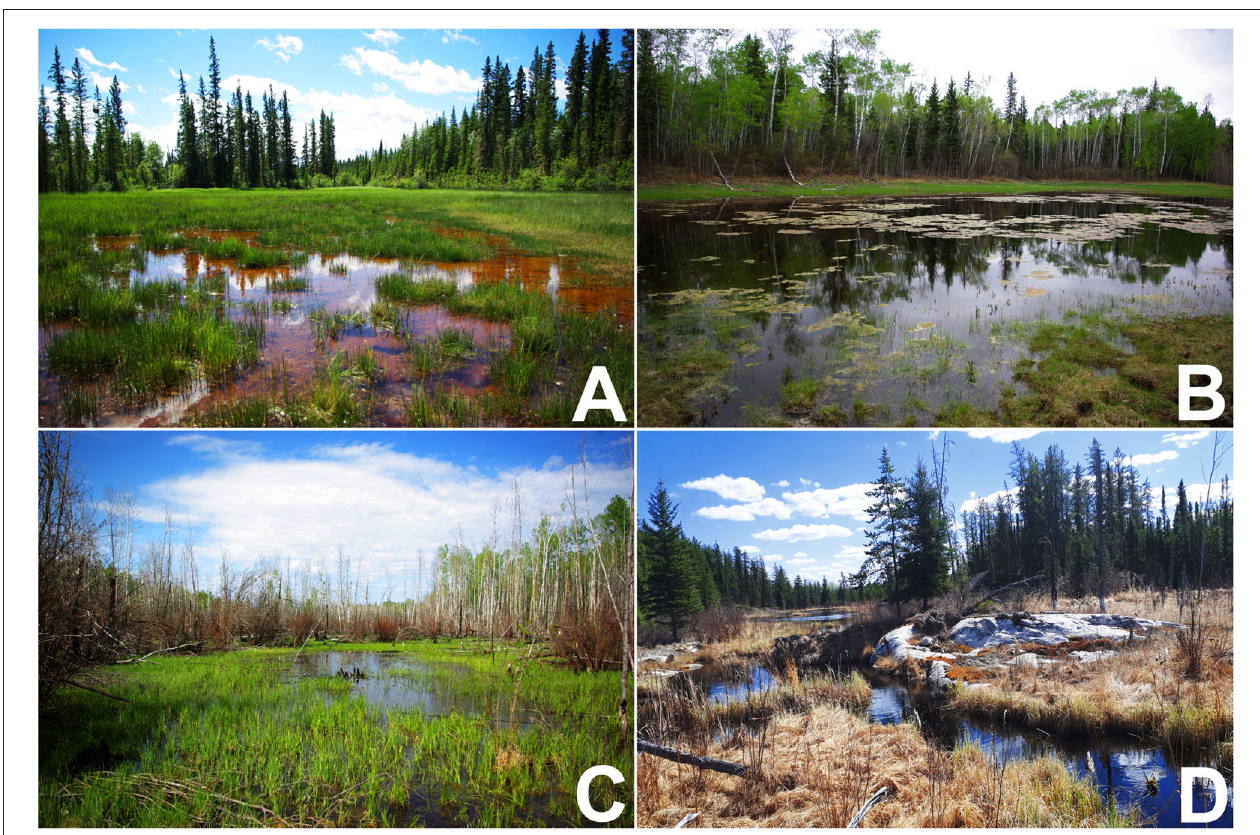
FIGURE 2 | Representative amphibian habitats sampled in Alberta and the Northwest Territories in 2016 and 2017: Shallow marsh (A) , water-filled sinkhole (B) , floodplain (C) , and interconnected ponds and streams (D) . All photos by JF Bienentreu.